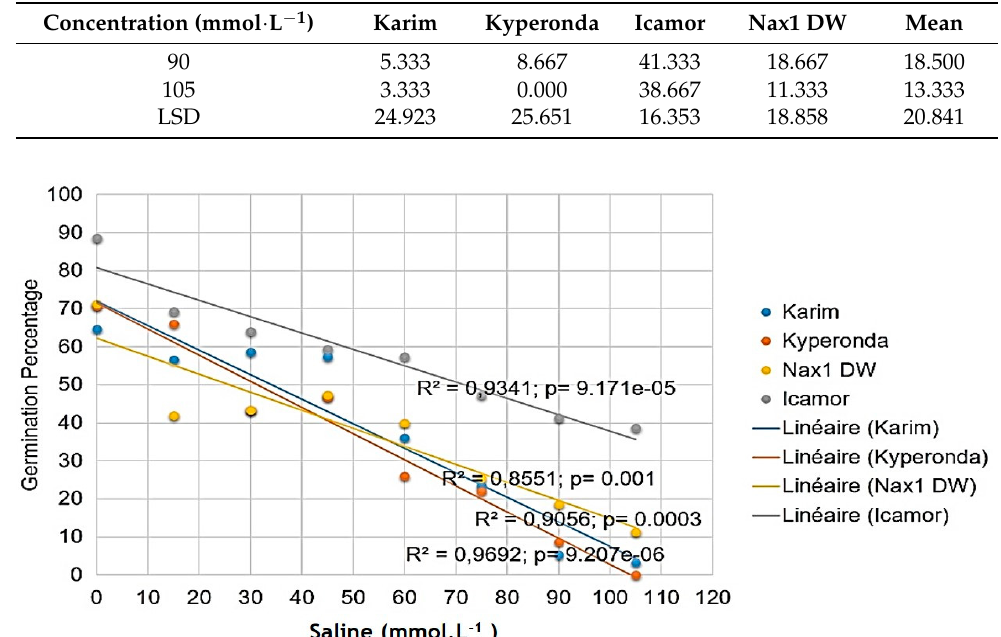
Figure 2. Regression analysis of the germination percentage for the four durum wheat genotypes under different concentrations of salt.